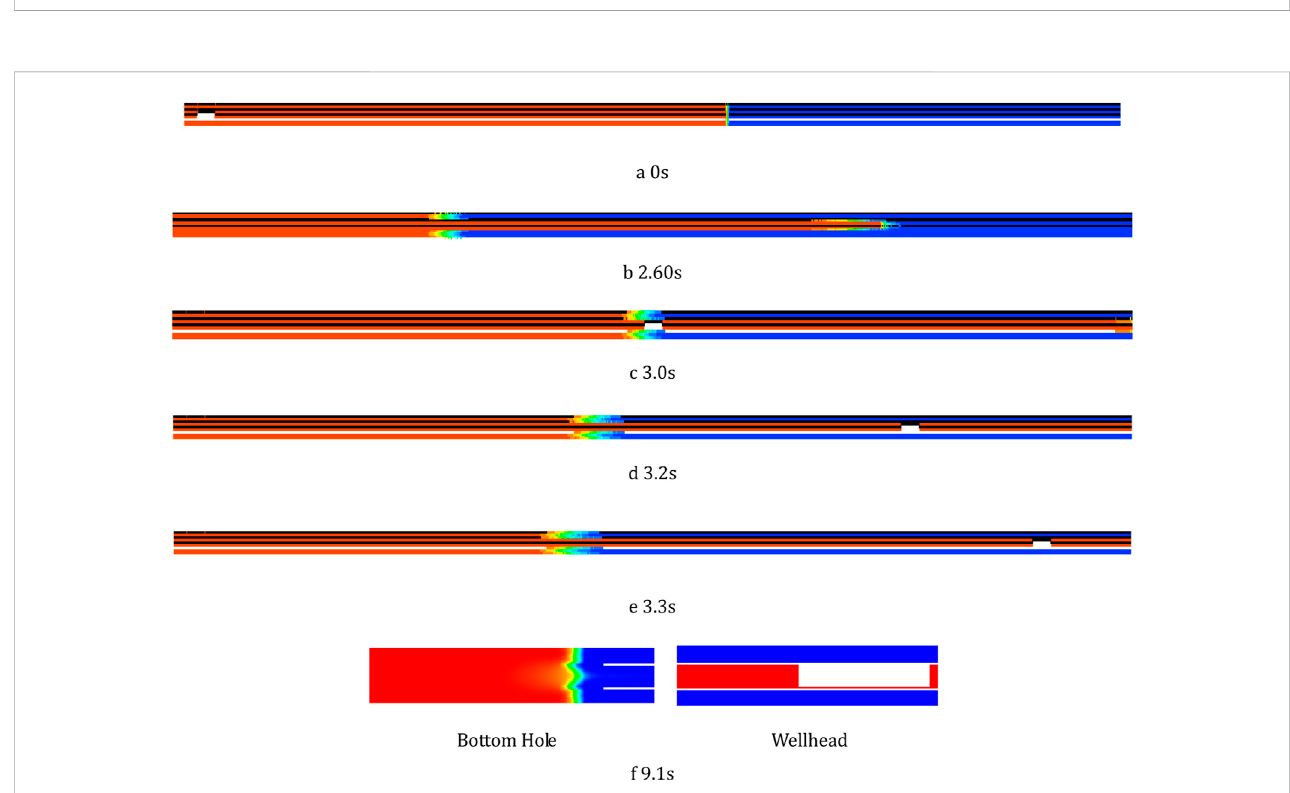
FIGURE 10 Liquid phase distribution (Red) during plunger gas lift. (A) 0. (B) 2.60. (C) 3.0. (D) 3.2. (E) 3.3. (F) 9.1